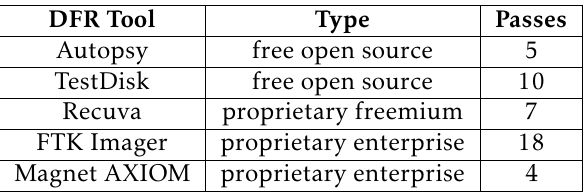
Table 1. DFR tools sorted by type. “Passes” refers to the number of test cases in which a tool fulfills all 4 core features.